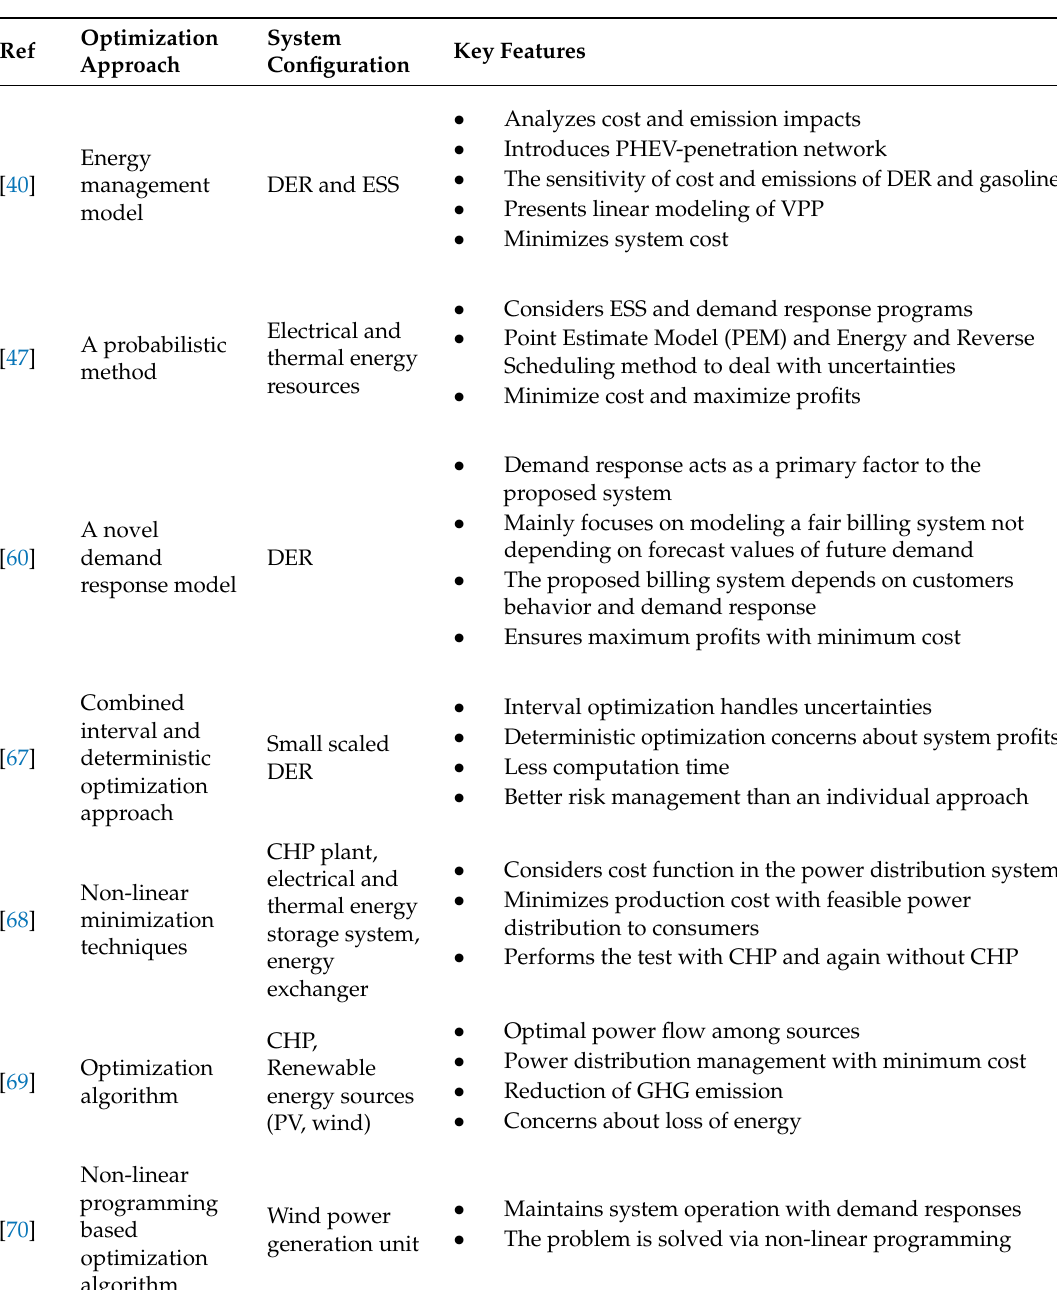
Table 1. A comparative analysis among di ff erent conventional approaches for virtual power plants.